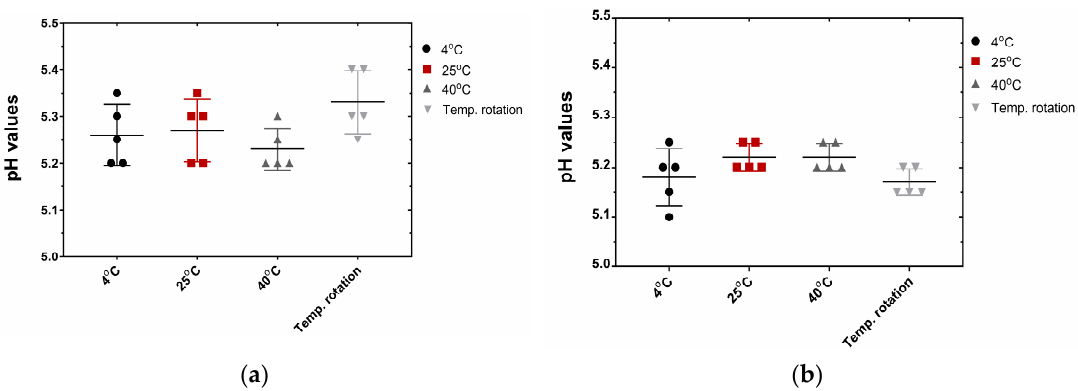
Figure 6. Skin care cream preliminary stability analysis at 4 °C, 25 °C, 40 °C, and after five temperature rotations: 24 h at 4 °C, and 24 h at 40 °C). ( a ): pH stability of the cream base (placebo). ( b ): pH stability of the cream loaded with R/LL + P extract.